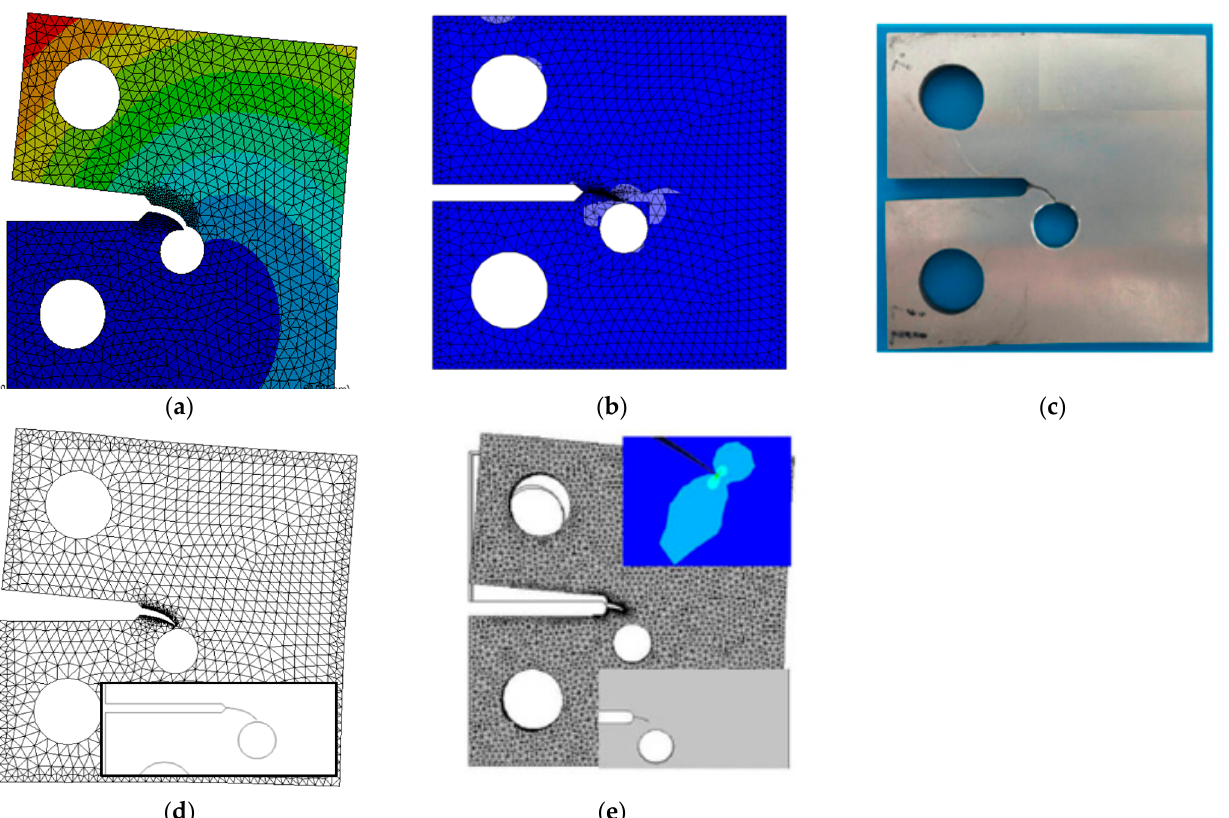
Figure 6. Predicted crack growth path for G2 specimen ( a ) ANSYS Workbench, ( b ) FRANC2D/L and ( c ) Experimental [32], ( d ) numerical [33], ( e ) FRANC3D [32].